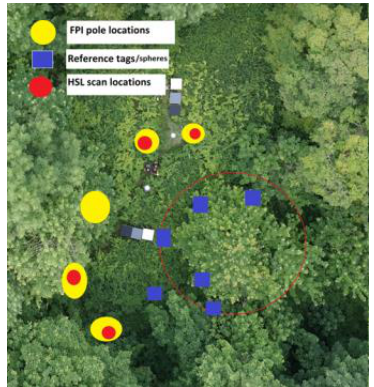
Figure 5. Approximate positions of the terrestrial stereoscopic imaging by FPI camera. Table 1. Paramters of image blocks. Dist: Nominal camera to object distance. V: vertical, O: oblique; T: terrestrial.